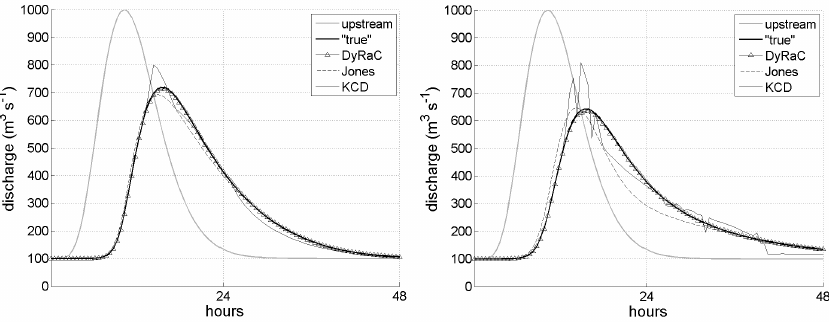
Fig. 1. Comparison of the discharge estimates based on DyRaC, Jones and KCD fromulas with the “true” values obtained using Hec-Ras Figure 1. Comparison of the discharge estimates based on DyRaC, Jones (HEC, 2001). The left figure refers to the case of 2 × 10 − 4 bed slope, while the right one to the case of 1 × 10 − 4 bed slope. Note the instabilities and KCD fromulas with the (cid:147)true(cid:148)values obtained using Hec-Ras (HEC, 2001). present in the KCD approach. The left (cid:133)gure refers to the case of 2 10 (cid:0) 4 bed slope, while the right one to the (cid:2) case of 1 10 (cid:0) 4 bed slope. Note the instabilities present in the KCD approach. (cid:2)